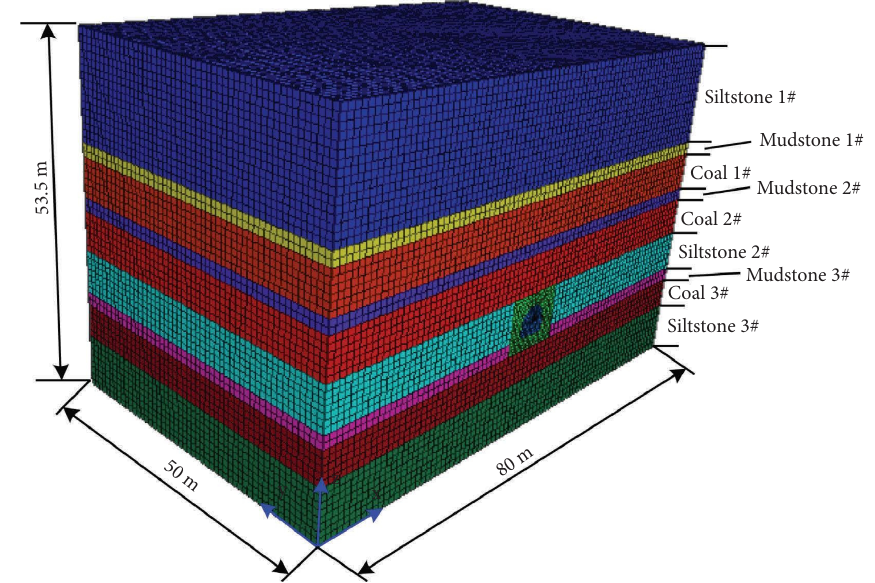
Figure 8: Numerical calculation model and